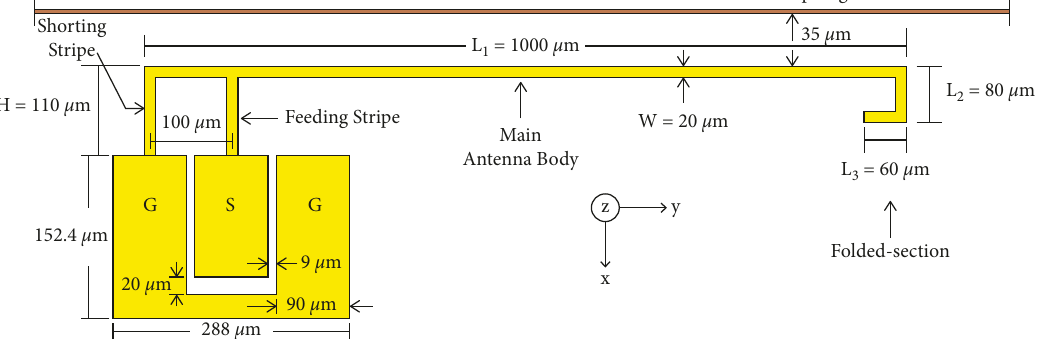
Figure 2: Design and dimensions of the proposed on-chip PIFA.